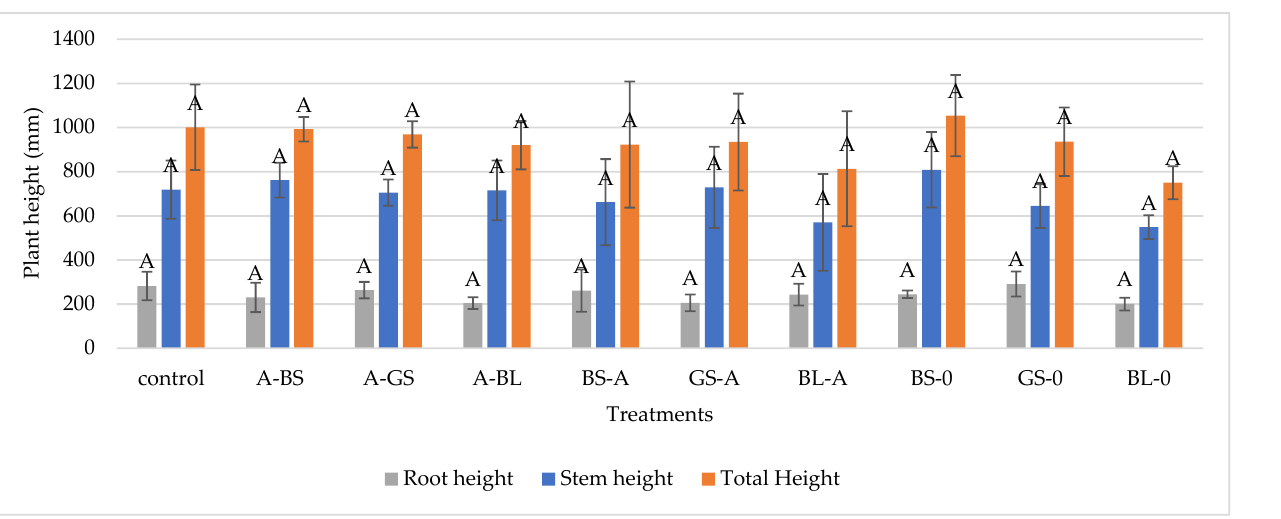
Figure 6. Results of biosurfactant treatments and fungal infections on the chlorophyll content com-